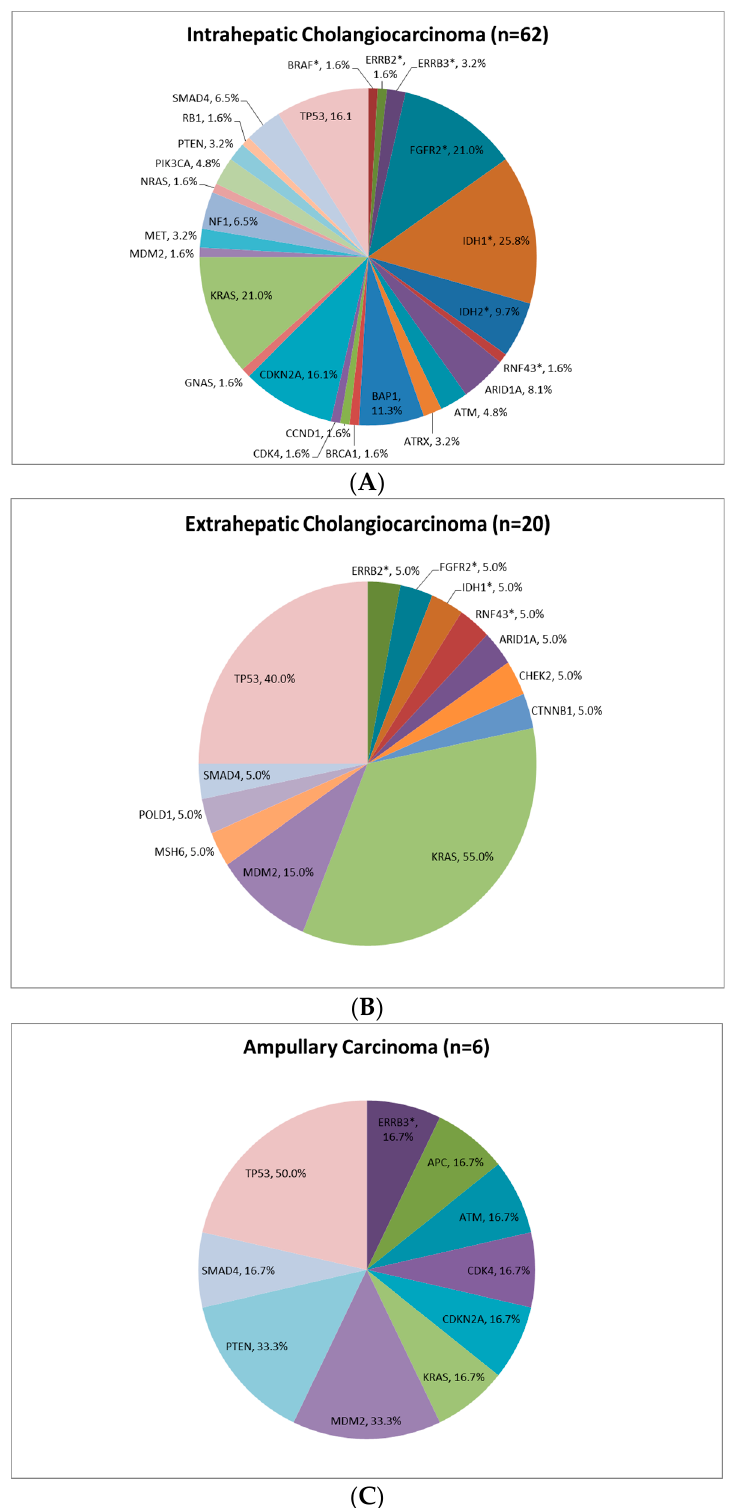
Figure 3. Molecular alterations by primary tumour site. Targetable findings were mainly identified in patients diagnosed with intrahepatic cholangiocarcinoma. * highlight potentially “targetable” alterations in biliary tract cancer. See Tables S2 and S3 for further details on full breakdown of findings and individual patient data, respectively. ( A ): Intrahepatic Cholangiocarcinoma ( n = 62); ( B ): Extrahepatic Cholangiocarcinoma ( n = 20); and ( C ): Ampullary Carcinoma ( n = 6). As a direct result of the pathological molecular findings, 11/104 patients (10.6% of the whole population; 11/89 (12.4%) of patients with successfully analysed samples) entered a clinical trial with